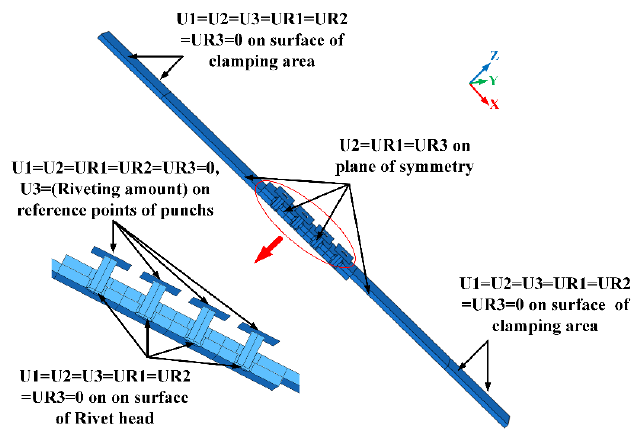
Figure 8. The boundary condition of the finite element (FE) model in the riveting steps.